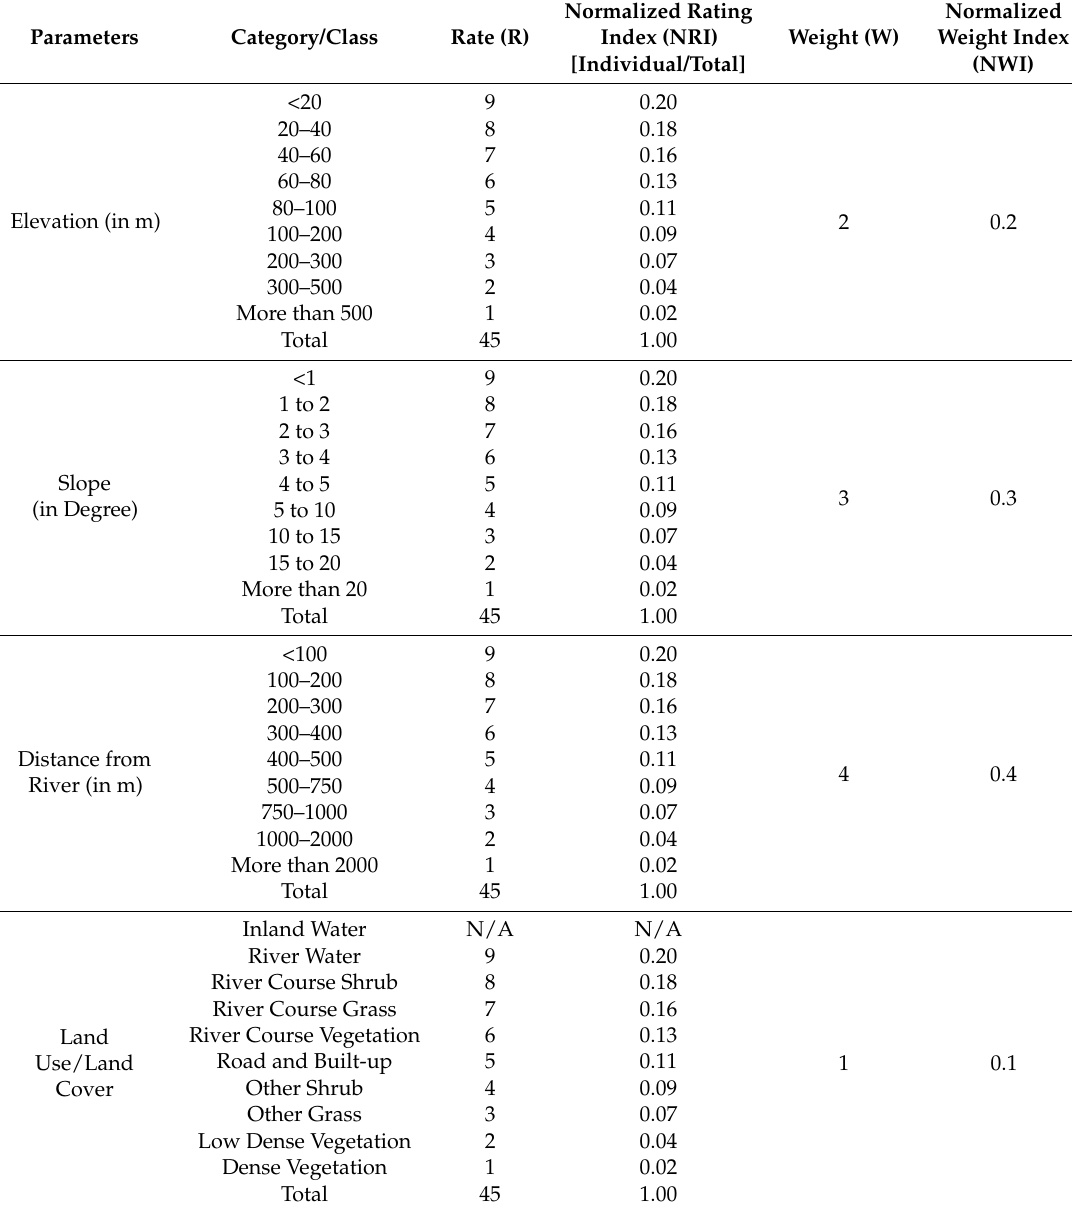
Table 3. Rate, normalized rating index, weight index based on